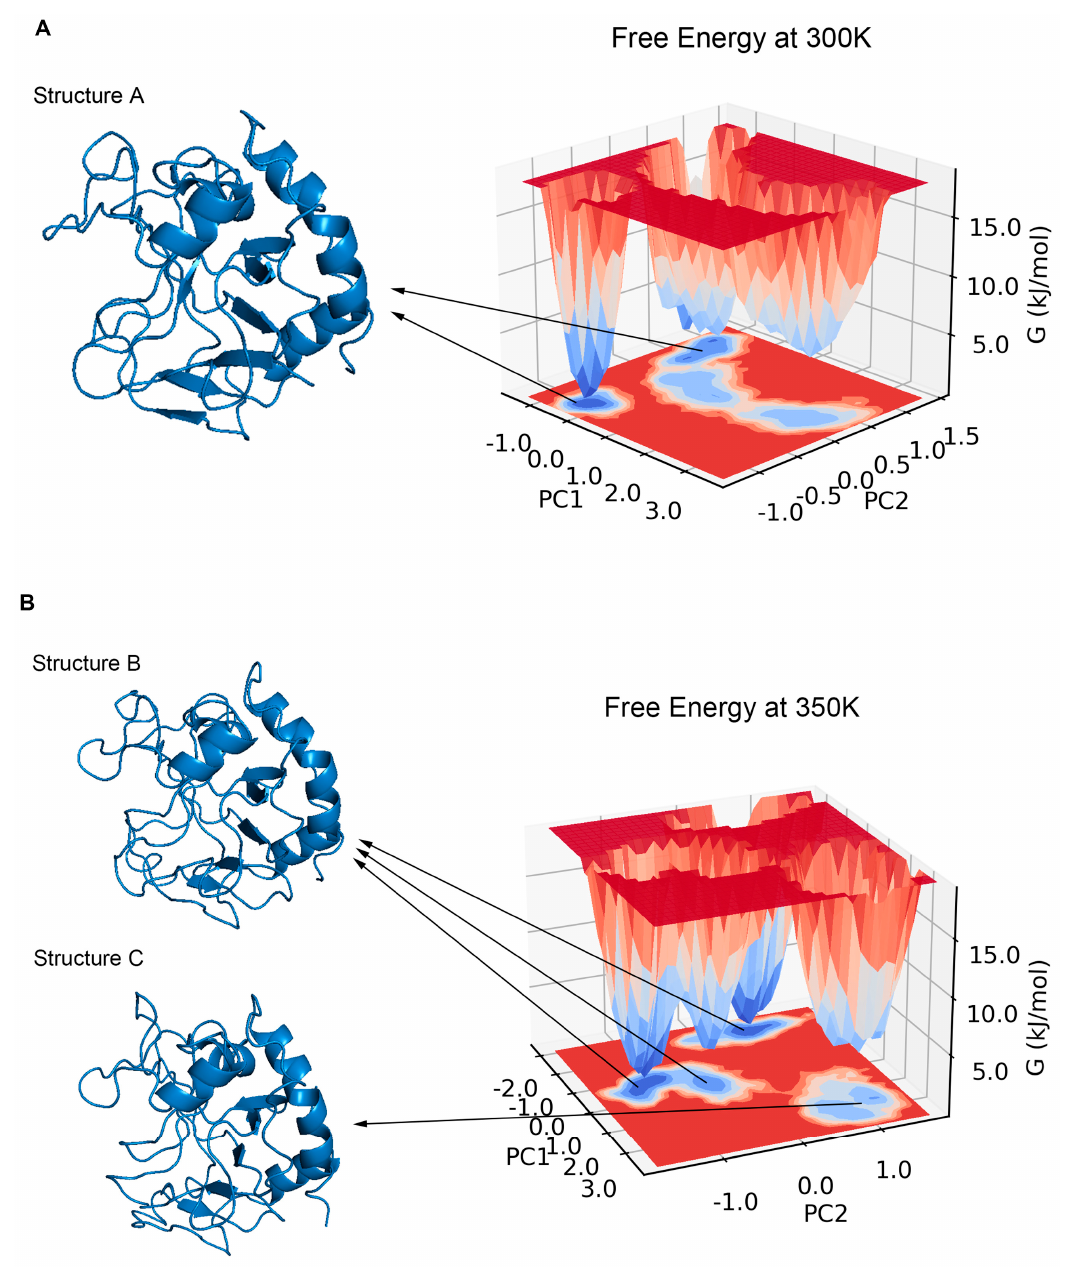
Figure 8. ( A ) shows the free energy landscape with two principal components at 300 K, all energy basins corresponded to the first structural cluster (structure A). ( B ) shows the free energy landscape with two principal components at 350 K, the three lowest basins corresponded to the first structural cluster (structure B), and the other basin corresponded to the second structural cluster (structure C).